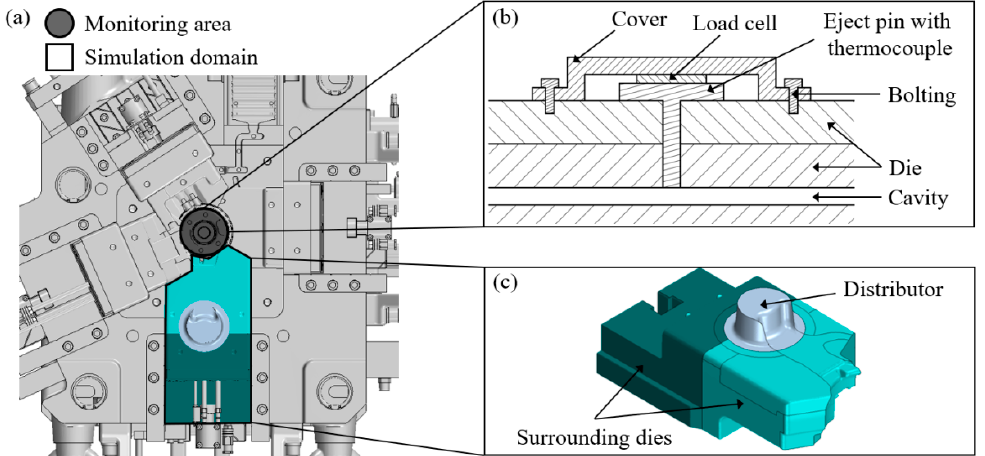
Figure 5. Numerical analysis parts and the data measuring method. ( a ) The locations of the moni- toring areas and analysis region. ( b ) The temperature and pressure measuring setup. ( c ) Numerical analysis model for distributor and the surrounding dies.